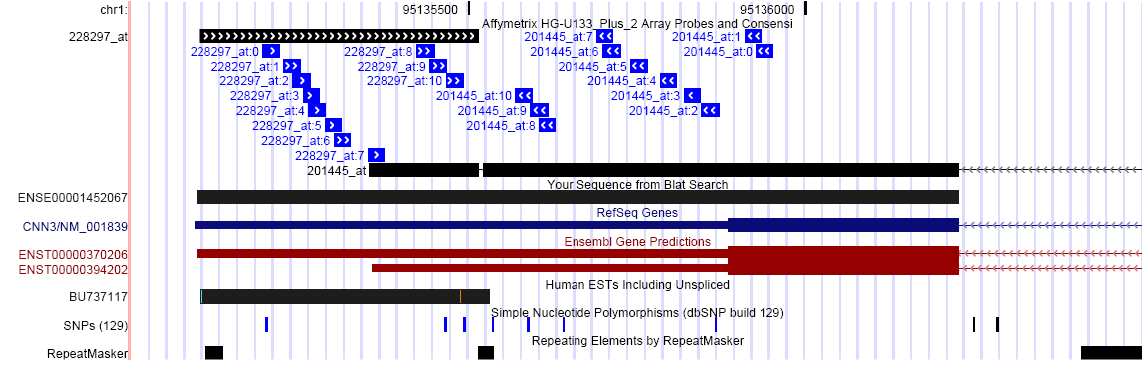
Figure S4. UCSC screen shot for